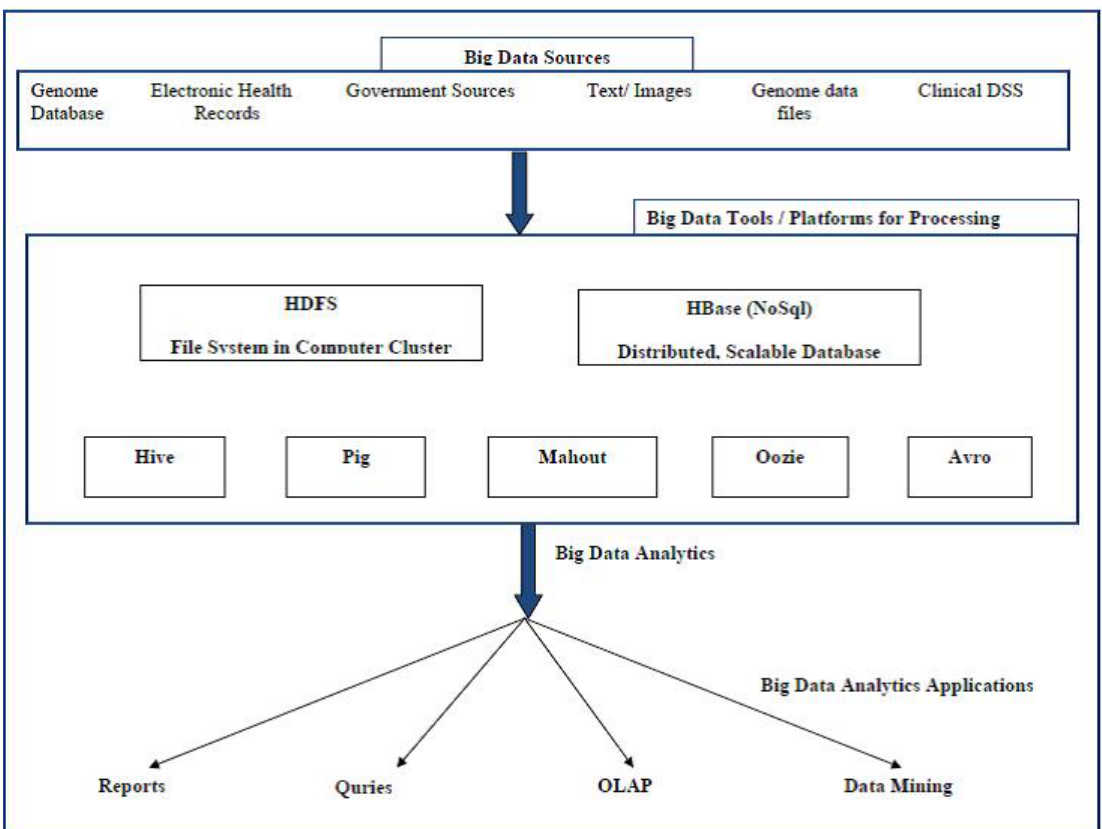
Fig. 3 Conceptual architecture of big data analytics for health informatics.